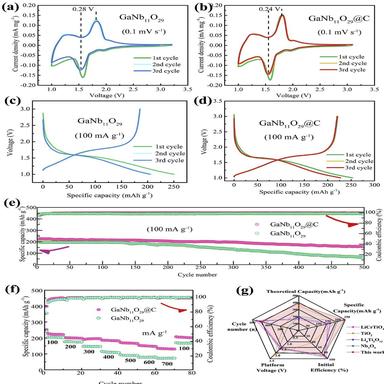
Cyclic voltammetry curves of (a) GaNb11O29 and (b) GaNb11O29@C. The galvanostatic cycling profiles of (c) GaNb11O29 and (d) GaNb11O29@C. (e) Cycling performance and (f) rate capability of GaNb11O29 and GaNb11O29@C. (g) A radar chart about performance comparison of GaNb11O29@C with other electrode materials.